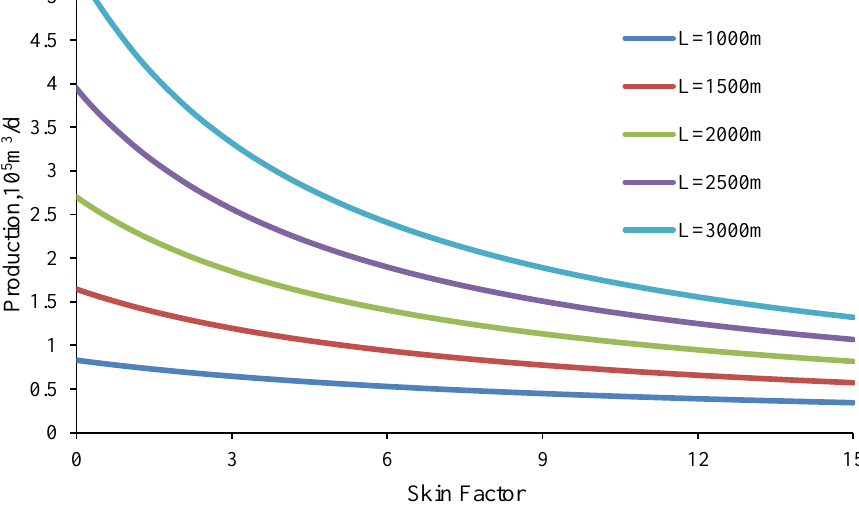
Figure 10—Effect of the formation damage on production at different horizontal well